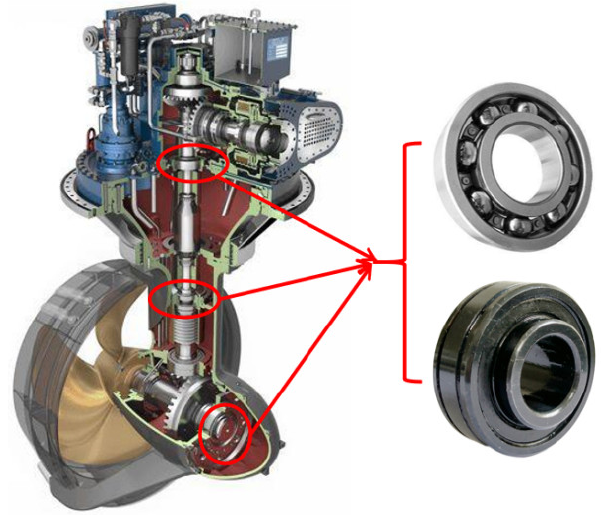
Figure 1. Rolling bearings in the marine powertrain.